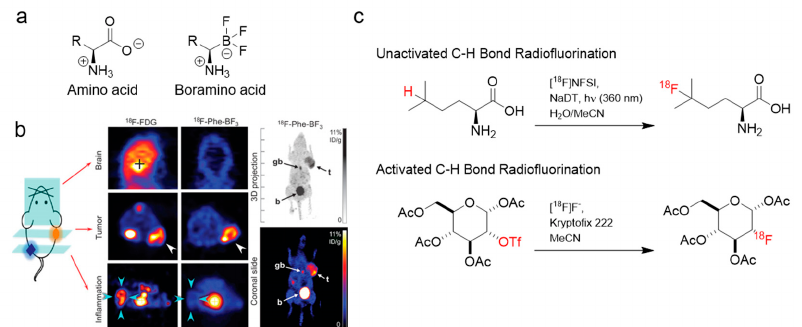
Figure 3. Examples of 18 F-labeled amino acid derivatives. ( a ) Representative structures of natural amino acids and the synthetic boramino acid variants. ( b ) In vivo PET projection images of [ 18 F]FDG and [ 18 F]Phe-BF 3 of the brain, U87MG tumor xenograft, and site of inflammation, respectively. Maximum intensity projection (MIP) images show activity accumulation in tumor, gallbladder, and bladder. Figure adapted with permissions from Sci. Adv. 2015 , 1(8): e1500694 [120], under a Creative Commons Attribution-NonCommerical (CC BY-NC 4.0) License. ( c ) Radiofluorination of an unactivated C–H bond (i.e., lacking a leaving group or an activating proximal functional group) and radiofluorination of